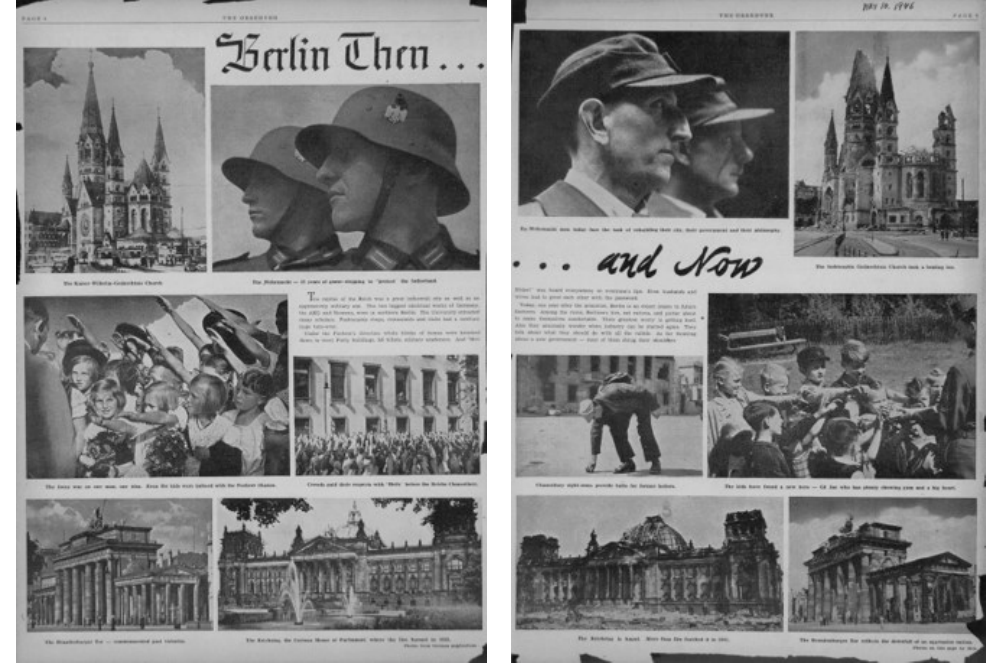
Figure 10. Henry Ries. “Before Then … and Now.” OMGUS Observer , 10 May 1946. Photograph. Author’s archives.